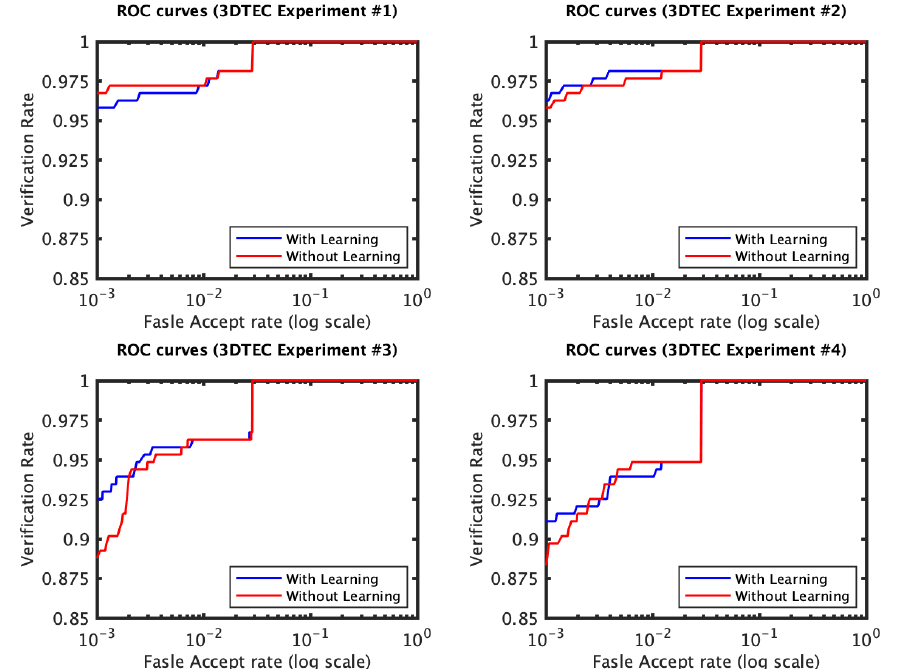
Figure 6. The ROC curves of the four 3D TEC experiments based on